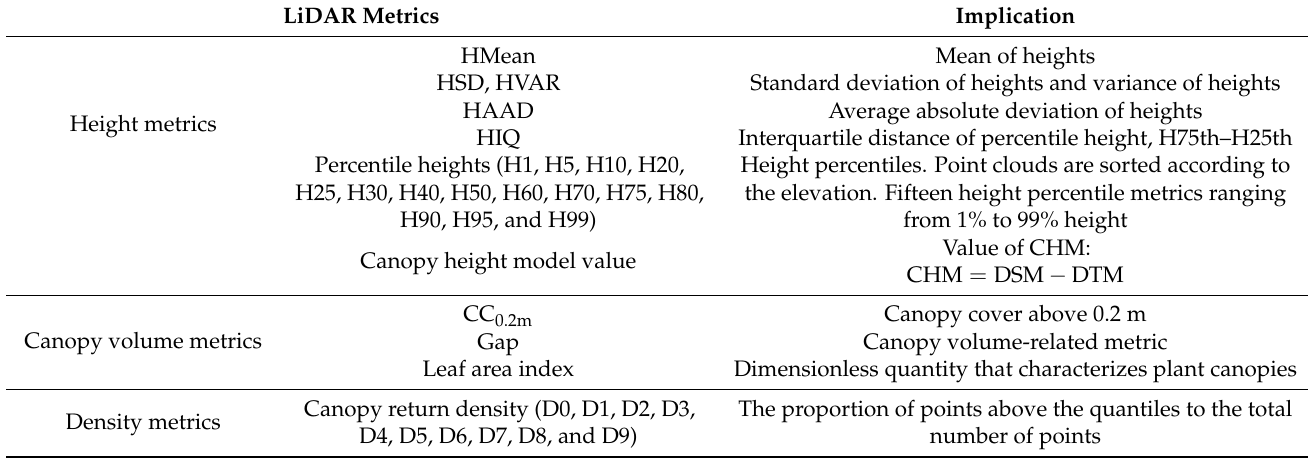
Table 1. List of metrics derived from the UAV-LiDAR/photogrammetric point clouds.